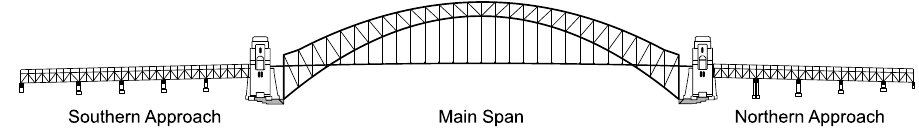
Figure 4. SHB schematic drawing (adapted from [112]).